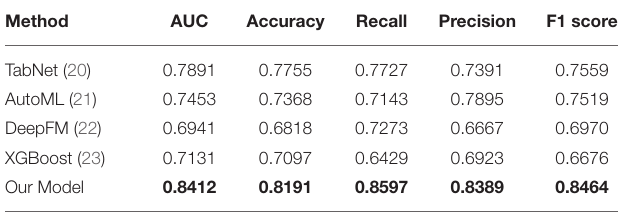
TABLE 3 | Comparison of general